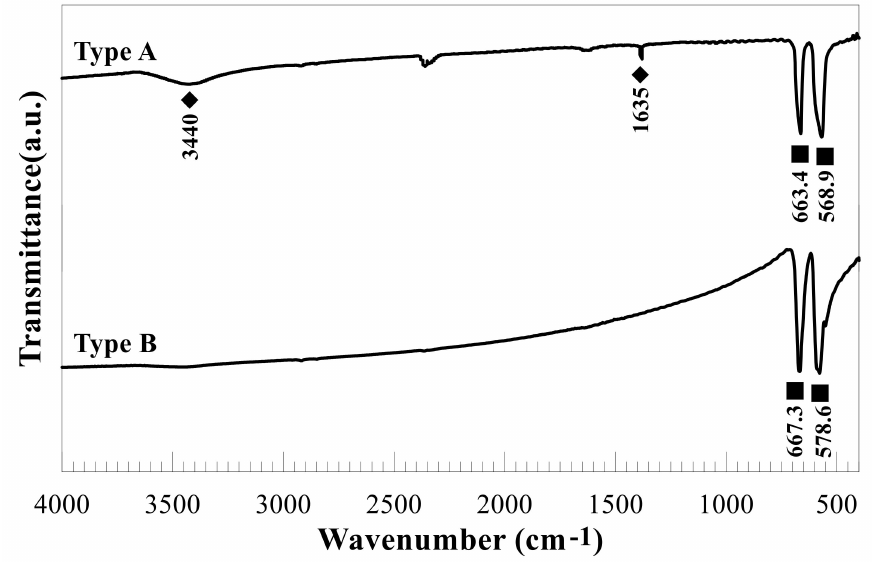
Figure 4. Fourier-transform infrared spectroscopy (FT-IR) spectra for the two types of Co-NPs of di ff erent